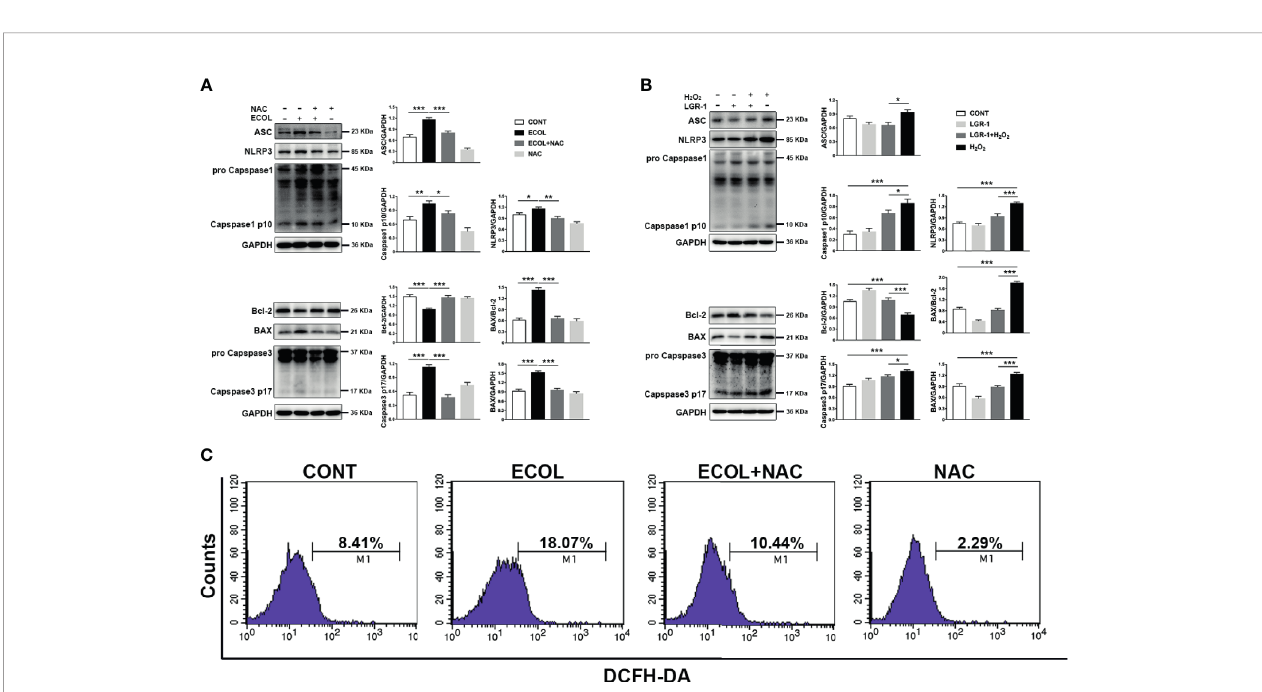
FIGURE 6 | Escherichia coli -induced NLRP3 in fl ammasome activation and apoptosis requires ROS production in MAC-T cells. (A, B) Western blot analysis of ASC, NLRP3, Caspase-1, BAX, Bcl-2, and Caspase-3. The right panel shows the protein quanti fi cation using ImageJ software (version 1.50). (C) Flow cytometry analysis of ROS. M1 represents the proportion of cells stained with DCFH-DA. MAC-T cells were pretreated with N-acetyl-L-cysteine (NAC, 5 mM) for 2 h and then exposed to E coli (MOI = 66) for 8 h or pretreated with LGR-1 for 3 h and then exposed to hydrogen peroxide (H 2 O 2 , 0.5 mM) for 0.5 (h) Data presented are mean ± SEM; n = 3. * p < 0.05, ** p < 0.01, *** p <